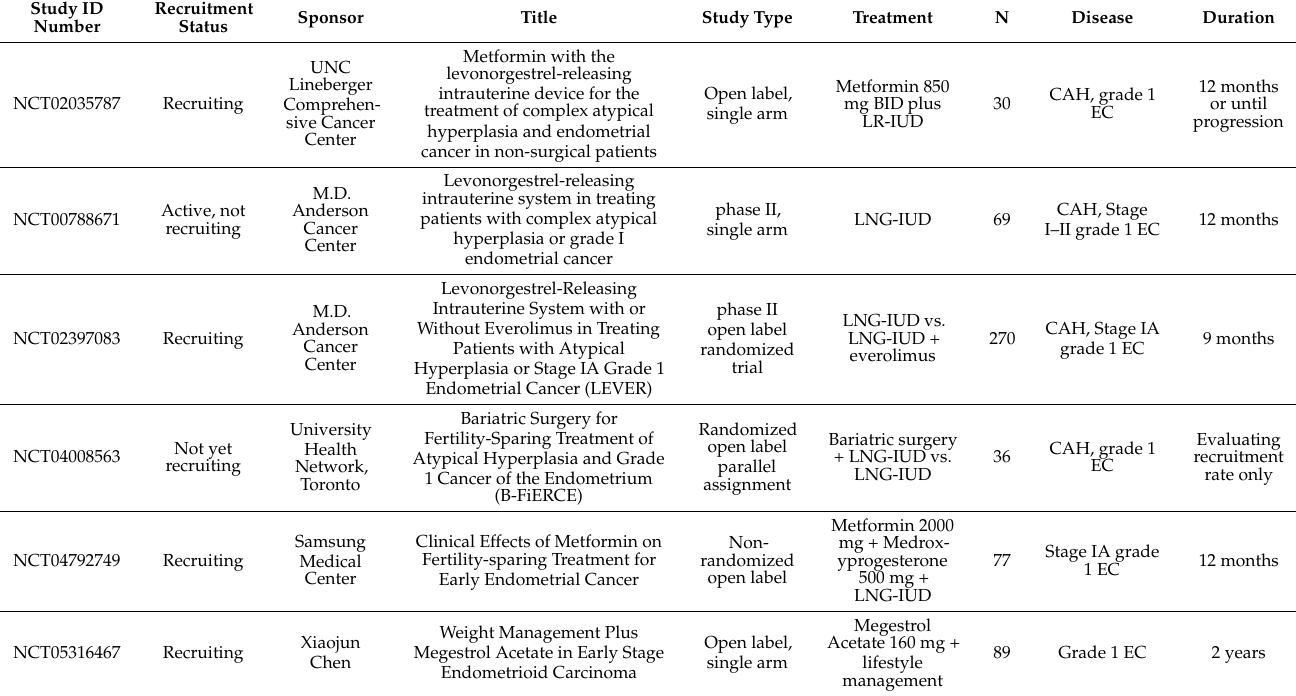
Table 1. Ongoing studies of fertility-sparing treatment of CAH and